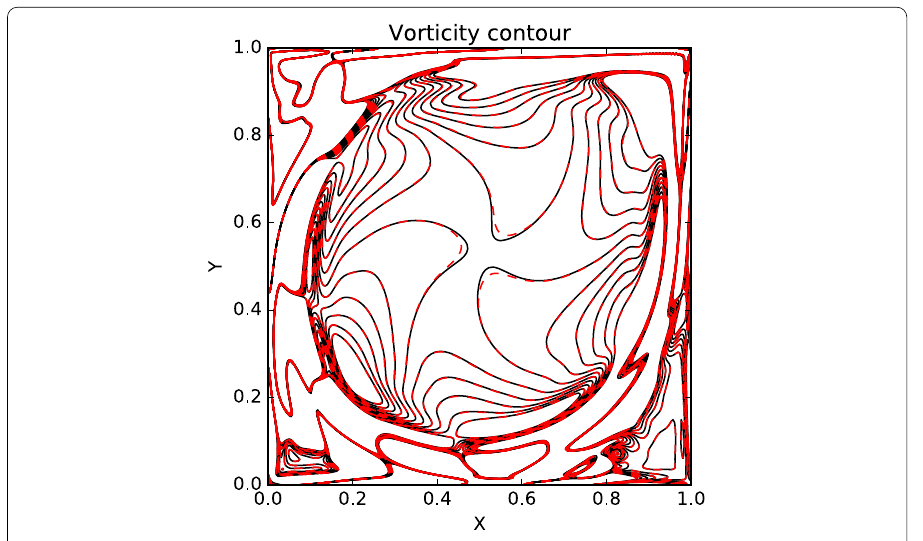
Fig. 9 Disturbance vorticity contour plot for reconstructed vorticity (solid lines) and DNS vorticity (dotted line) field at nondimensional time t = 1900 . 199 for target Re = 9600 with donor points { 9350 , 9500 , 9800 and 10 , 000 }